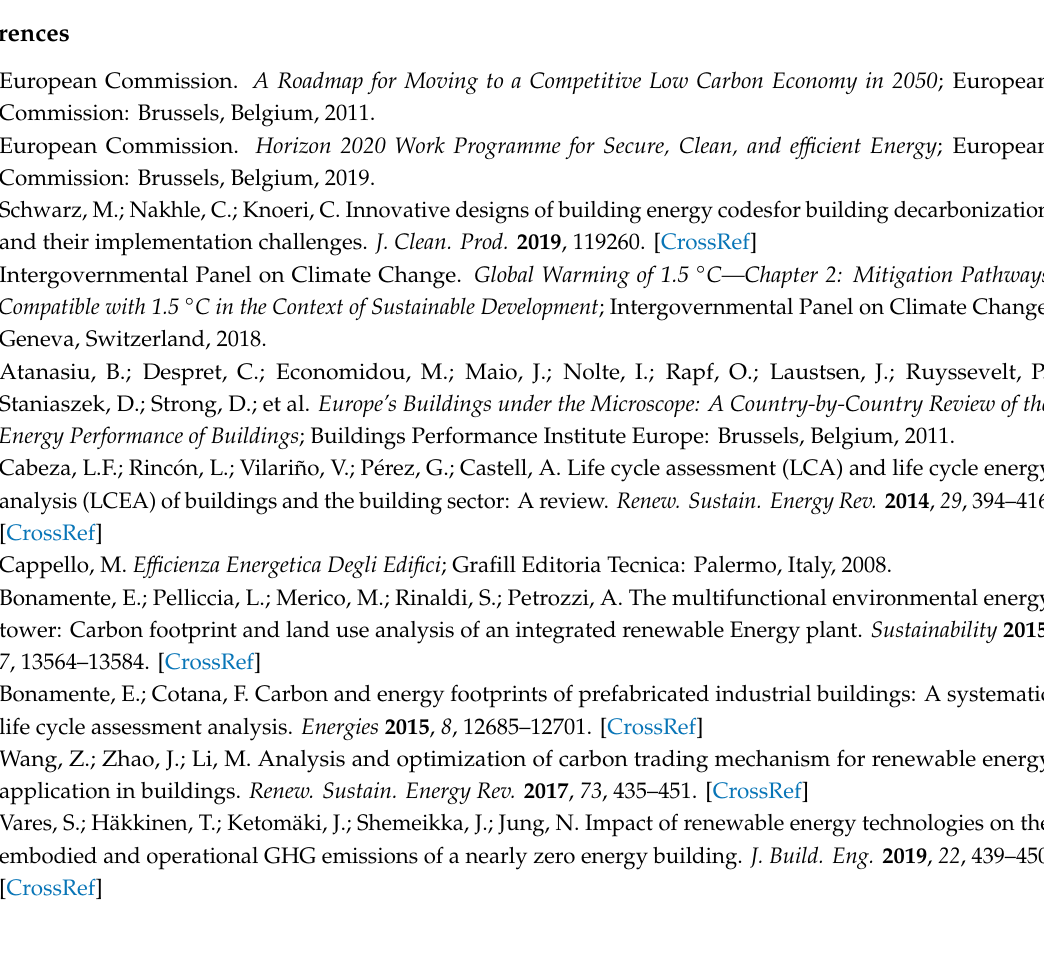
Table S1: Mid-point indicators (CML-IA baseline V3.05) for the three scenarios (electricity from grid), Table S2: Mid-point indicators (CML-IA baseline V3.05) for the three scenarios (electricity from PV), Table S3: Incidence of most-impacting processes (BAS, grid), Table S4: Incidence of most-impacting processes (SH-TES, grid), Table S5: Incidence of most-impacting processes (PCM-TES, grid), Table S6: Incidence of most-impacting processes (BAS, PV), Table S7: Incidence of most-impacting processes (SH-TES, PV), Table S8: Incidence of most-impacting processes (PCM-TES,